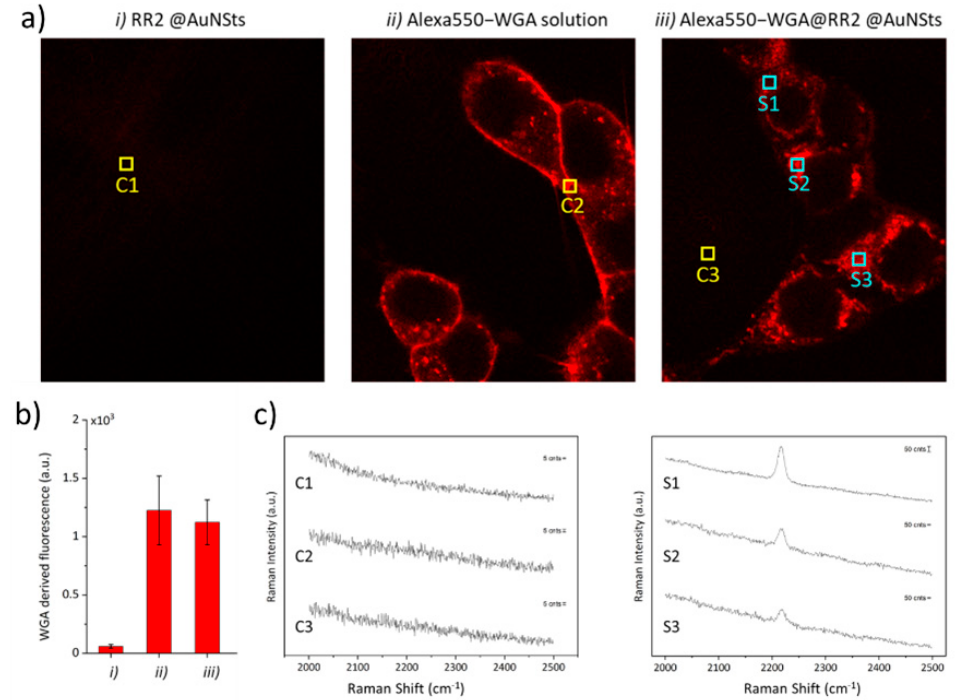
Figure 7. ( a ) Representative confocal microscope images of HEK cells incubated with RR 2 @AuNSts, free WGA solution, and Alexa550 ‐ WGA@RR 2 @AuNSts. Scale bar is 100 μ m in all cases. ( b ) Histogram showing the quantitative values of WGA fluorescence measured for the three samples after background subtraction. Error bars are standard deviations. ( c ) SERS spectra from random regions in ( a ), indicated by colored squares (C—control; S—sample).